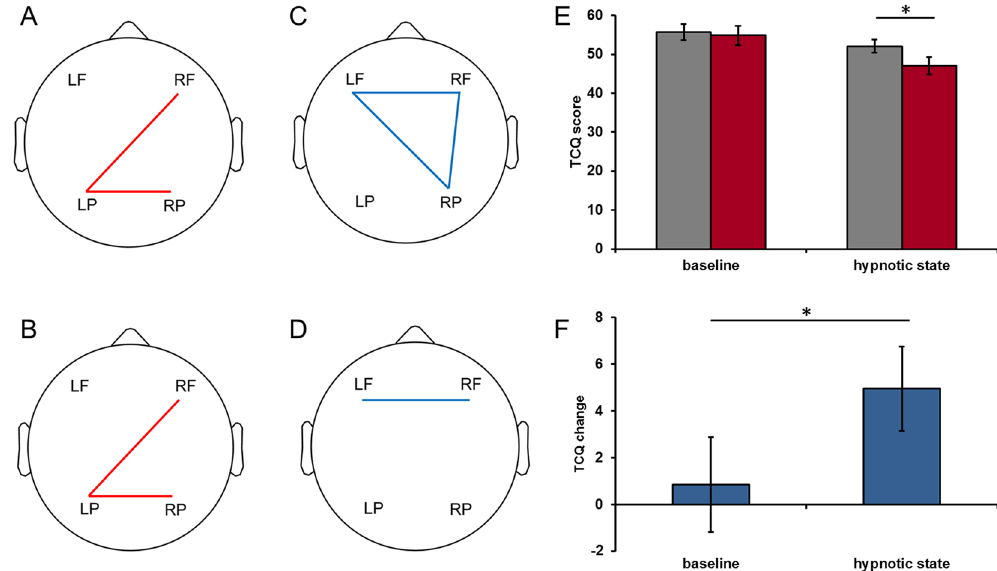
Figure 1. EEG coherence in four difference frequency bands and the TCQ score chang. ( A ) Delta coherence (RF-LP, LP-RP); ( B ) Theta coherence (RF-LP, LP-RP); ( C ) Alpha coherence (LF-RF, LF-RP, RF-RP); ( D ) Beta coherence (LF-RF); ( E ) The TCQ scores in the baseline and the hypnotic state; ( F ) The TCQ score change (TCQ scores measured before EEG scan – TCQ scores measured after EEG scan) in the baseline and the hypnotic state. Color coding: red (hypnotic state > baseline), blue (hypnotic state < baseline). TCQ: Tobacco Craving Questionnaire.